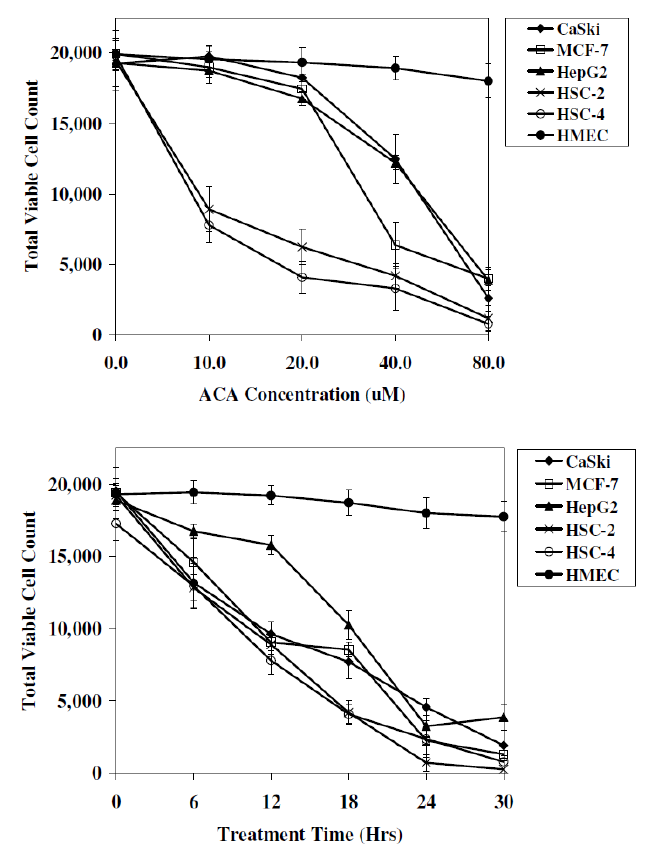
Figure 3. The cytotoxic effects of ACA on tumour cell lines assessed using the MTT cell viability assay. ( A ) Comparison of total viable cell count between various tumour cell lines after treatment with ACA at different concentrations (0–80.0 µ M) at 12 hrs post-treatment time. ( B ) Comparison of total viable cell count between various tumor cell lines after treatment with 40.0 µ M ACA for 30 hrs. All experiments were plotted as mean values (n =